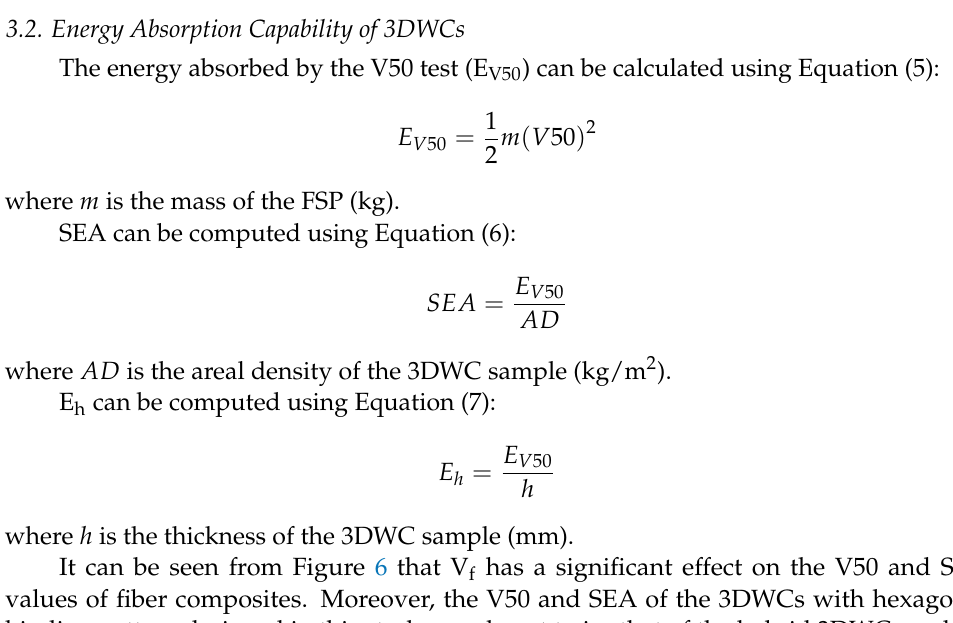
Figure 5. Results of ballistic impact tests, V s *-V f and V50*-V f . (Note: Both V s * and V50* are normalized with the corresponding values of sample I.).